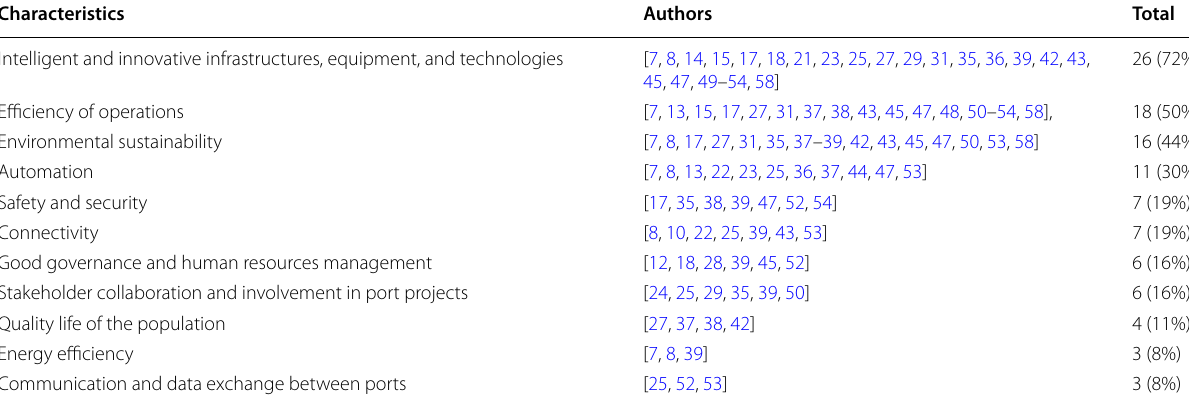
Table 4 Summary of the grouped smart port characteristics Characteristics